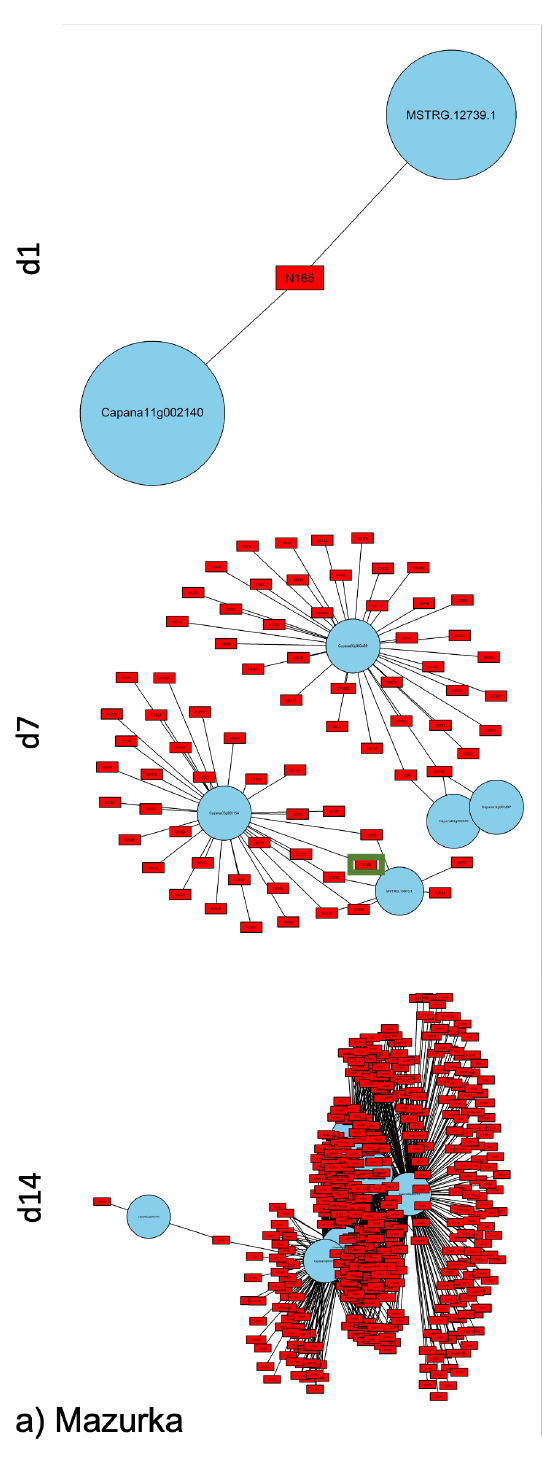
Figure 9. Network analysis of all secondary metabolites genesin Mazurka ( a ) and CAP1035 ( b ). Secondary metabolite genes that correlated to at least one mass feature with r > 0.9 for our six groups were used for a network analysis. Genes are plotted with blue circles and mass features with red rectangles. At d7, putatively annotated metabolites are highlighted in